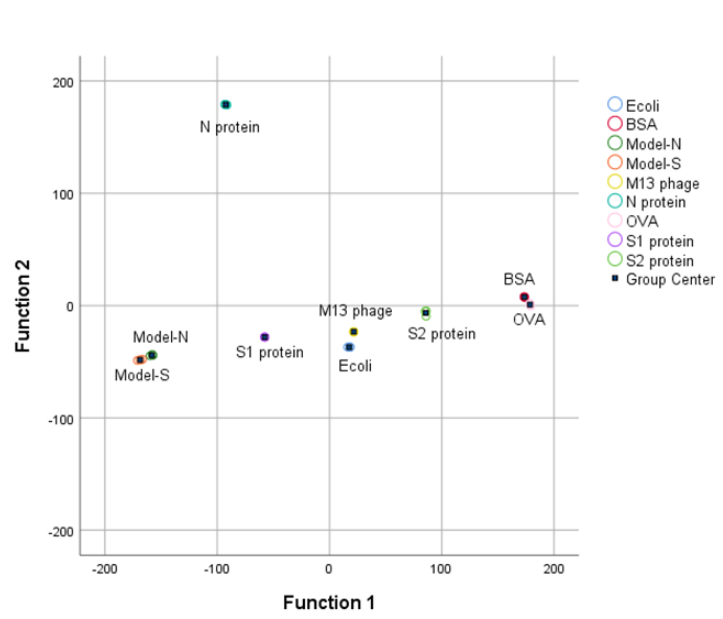
Figure 5. RS Group center plot for the nine samples after LDA analysis. Apart from that, based on the results from cross-validation (see Table 7), 66.7% of Model − N can be identified correctly, and 33.3% for false recognition as Model − S. Beyond